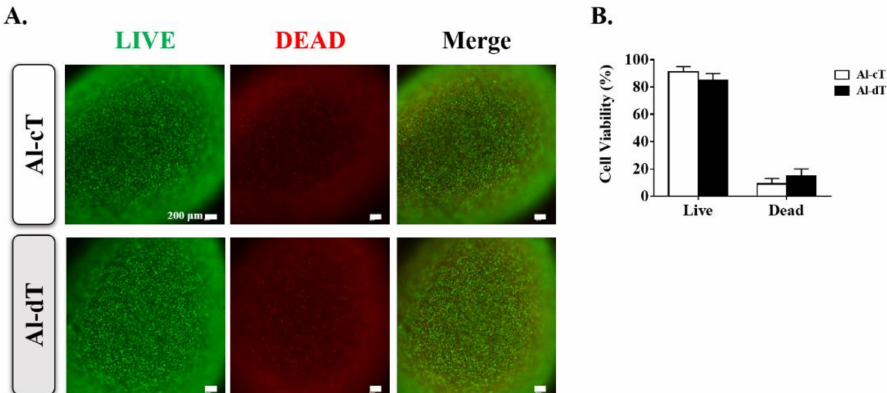
Figure 2. The cell viability analysis of alginate microbeads. The in vitro cell viability was evaluated using a Live/Dead assay. ( A ) Live/Dead assay performed at day 7. Staining of Al-cT and Al-dT for live cells (green) and dead cells (red). ( B ) Quantification analysis of fluorescence intensities. The results are representative of at least three independent experimental repeats. Bars indicate the mean ± S.D.